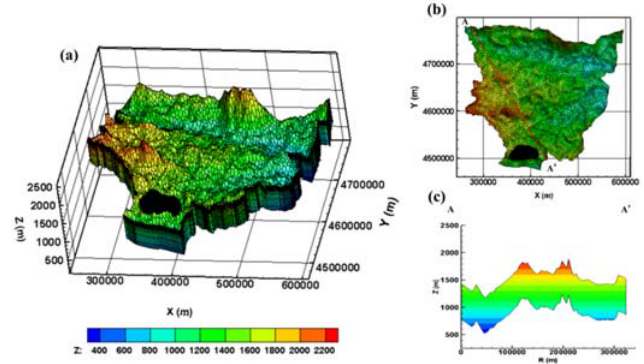
Figure 4. Mesh of the study area (scale ratio of x:y:z = 1:1:65): ( a ) three ‐ dimensional mesh; ( b ) mesh of Horizontal plan; and ( c ) elevation of profile A ‐ A’.